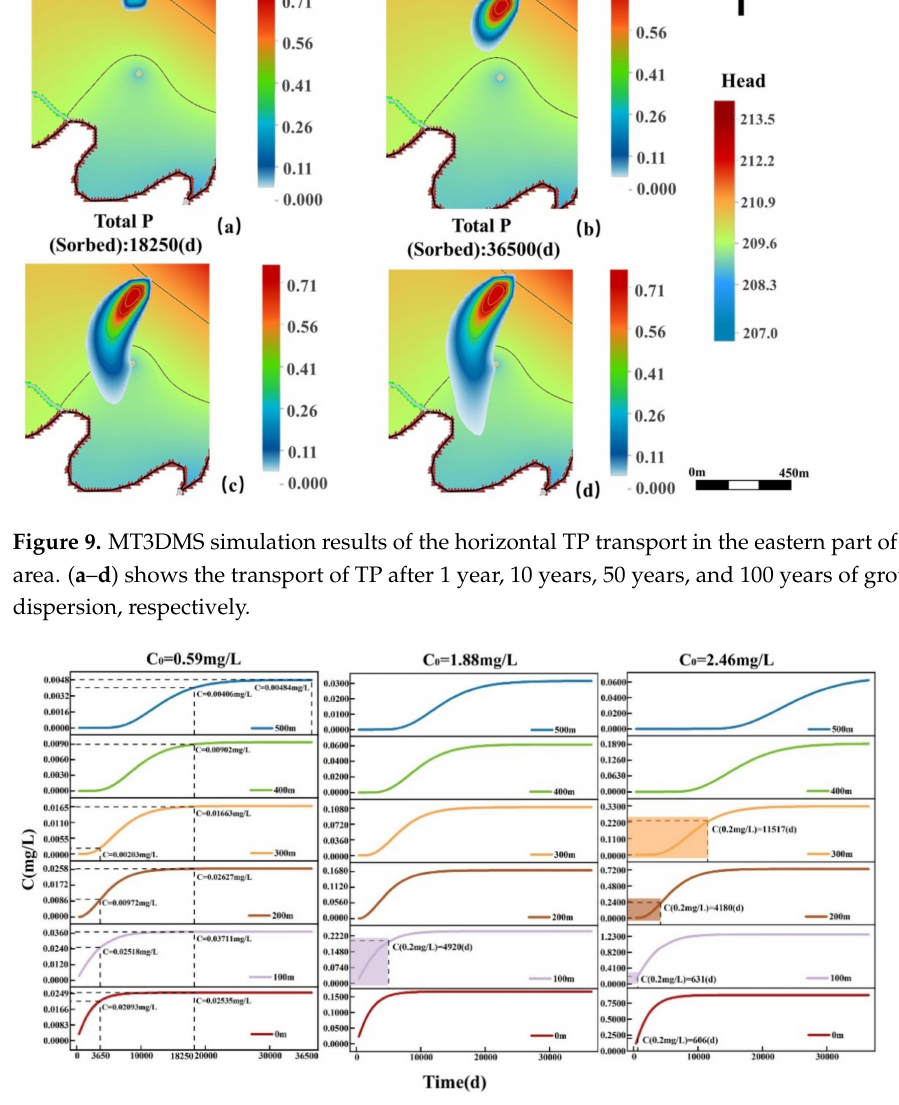
Figure 10. Changes in the spatiotemporal TP transport in the eastern part of the study area under different source